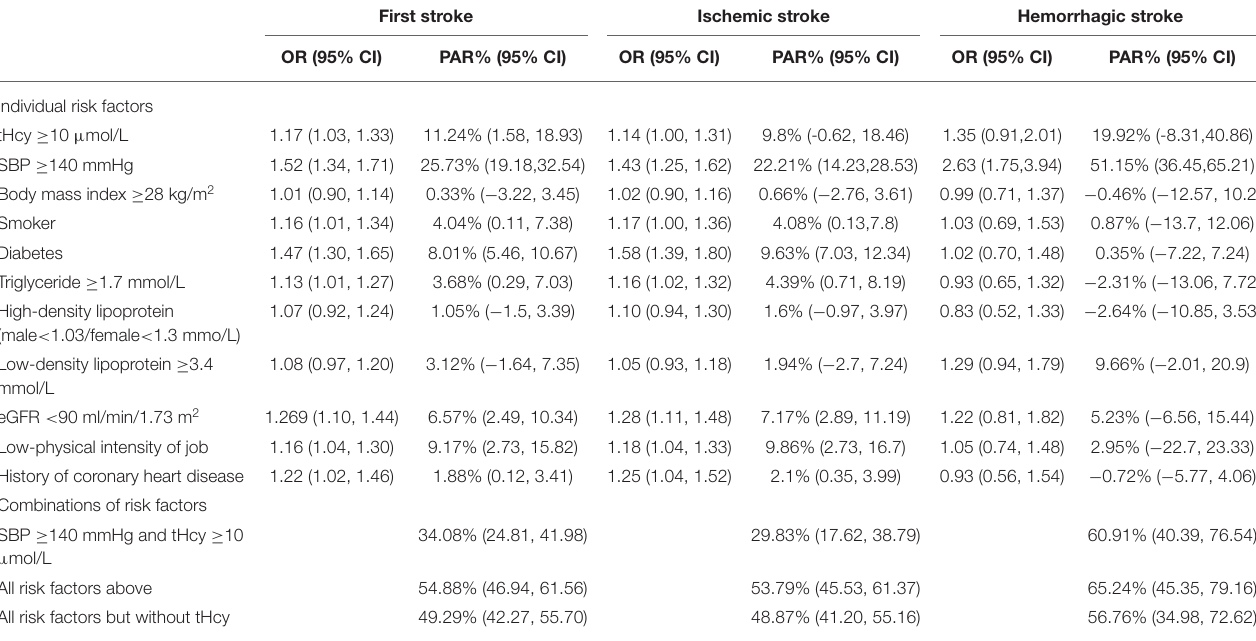
TABLE 4 | Adjusted odds ratio and population attributable risks for first stroke, ischemic stroke, and hemorrhagic stroke. First stroke Ischemic stroke Hemorrhagic